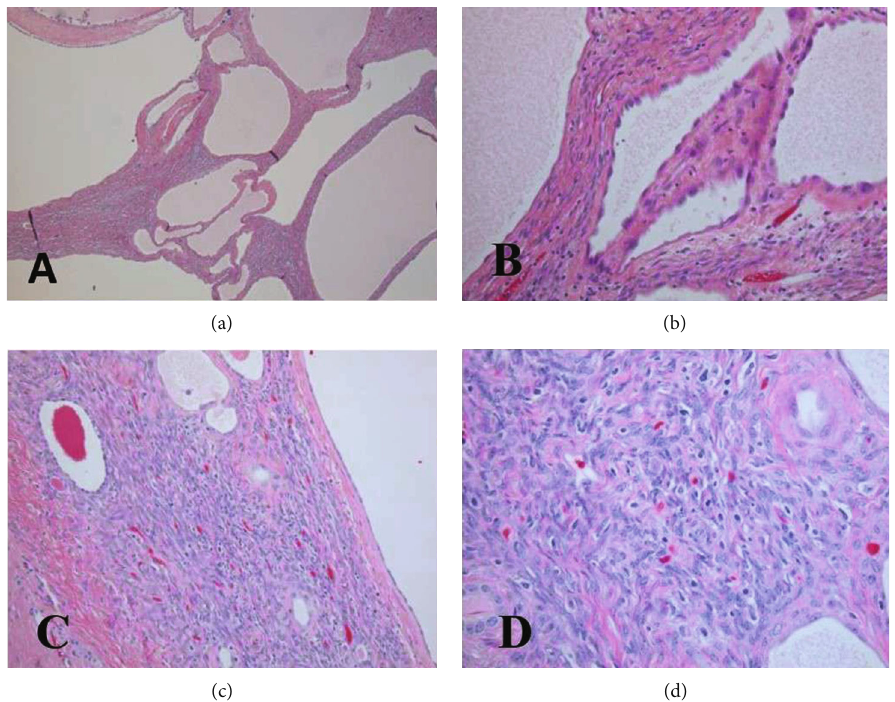
Figure 2: (a) Hematoxylin and eosin sections from the neoplasm. The tumor consists of cysts of variable sizes separated by septae and mesenchymal stroma (40x). (b) Higher magni fi cation from the tumor showing cysts lined by fl attened and cuboidal epithelium with hobnail appearance of nuclei in some areas (100x). (c) Ovarian type stroma is present in some areas (40x). (d) Higher magni fi cation showing ovarian type stroma (100x).